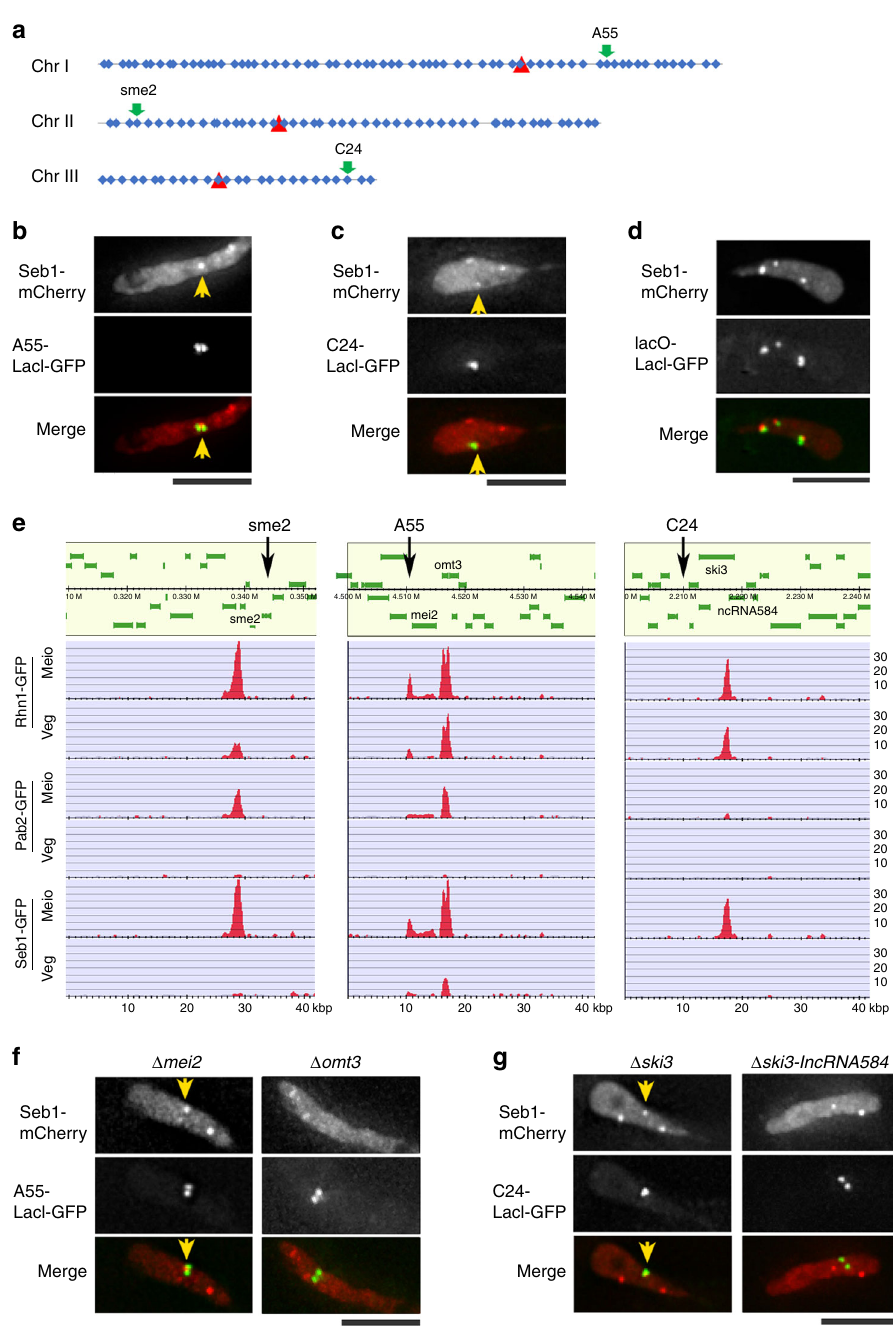
Fig. 2 Identi fi cation of Smp dots and their role in homologous pairing. a A map of a lacO insertion library of the S. pombe genome, composed of the following three chromosomes: average intervals of 82 kbp on chromosome I (Chr I), 90 kpb on chromosome II (Chr II), and 95 kpb on chromosome III (Chr III). Blue diamonds show the loci for lacO insertion. Red triangles indicate the position of the centromere. The complete list of lacO -insertion loci is provided in Supplementary Table 1. b , c Localization of A55- lacO /LacI-GFP b or C24- lacO /LacI-GFP c with one of the Seb1-mCherry dots. Arrows indicate the co-localized position. d Co-localization of Seb1-mCherry dots with lacO /LacI-GFP at the A55, C24, and sme2 loci. e ChIP-seq data of Rhn1, Pab2, and Seb1 in meiotic (Meio) and vegetative (Veg) cells. Arrows indicate the lacO -insertion sites at sme2 (left), A55 (middle), and C24 (right). The map of the S. pombe genome was obtained from the PomBase public database (https://www.pombase.org). The complete data from the genome-wide ChIP-seq are shown in Supplementary Data 1. f Localization of A55- lacO /LacI-GFP and Seb1-mCherry in mei2 deletion (left) and omt3 deletion (right) mutants. Arrows indicate the co-localized position. g Localization of C24- lacO /LacI-GFP and Seb1-mCherry in Δ ski3 (left) and Δ ski3-lncRNA584 (right) mutants. Arrows indicate the co-localized position. Scale bar, 5 μ m b , c , d , f , g